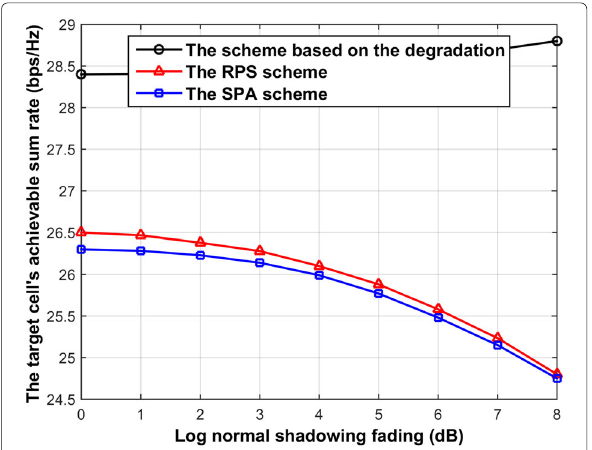
Fig. 4 The impact of shadowing fading on the target cell’s achievable sum